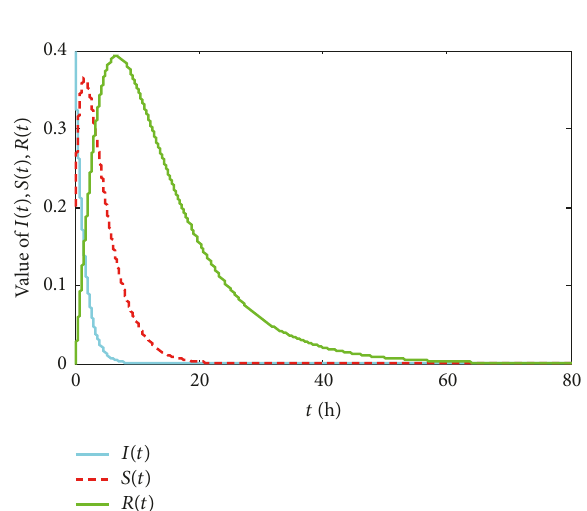
Figure 6: System stability simulation of system.